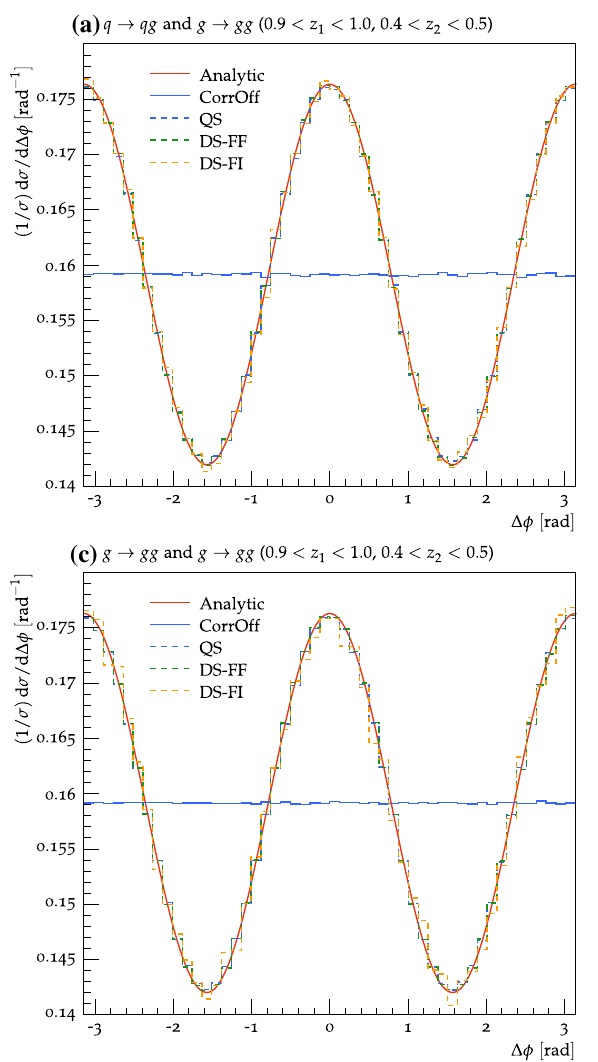
Fig. 1 Theanalyticresultforthedifferenceinazimuthalanglebetween the branching planes of subsequent final-state a q → qg and g → gg , b q → qg and g → q ¯ q , c g → gg and g → gg , and d g → gg and g → q ¯ q splittings compared to the distributions predicted using the angular-ordered (QS) and dipole parton showers in Herwig 7. The pre-